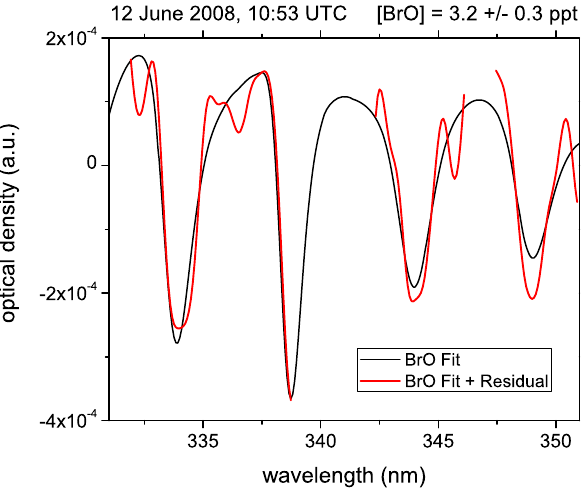
Fig. 2. Comparison of the BrO absorption structure in an atmo- spheric spectrum after removing the absorptions of ozone, HCHO, and O 4 with a BrO reference spectrum (Fleischmann et al., 2004). The spectral regions from 338.7–342.3nm and 346.1–347.4nm were excluded from the fit to reduce interferences due to instru- mental